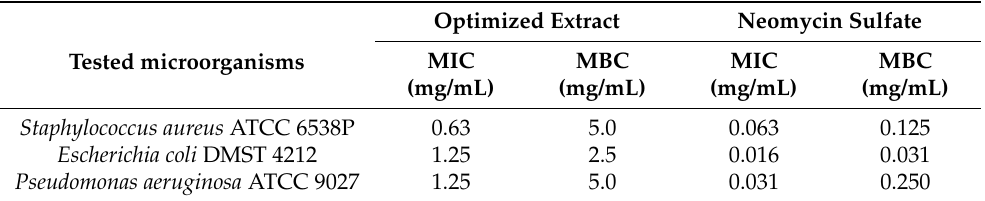
Table 8. Minimum inhibitory concentration (MIC) values of rhein-rich extract.